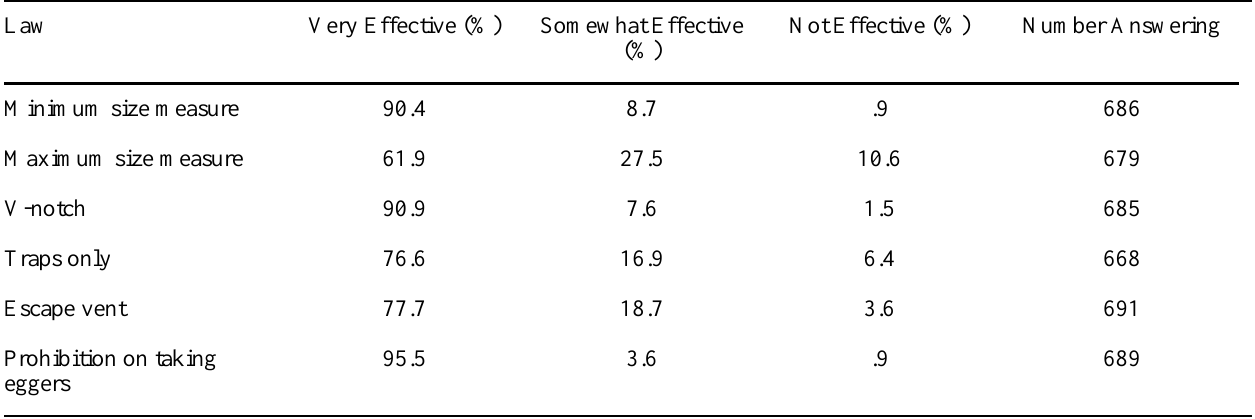
Table 1. Fishermen’s responses to the question ‘How effective are each of the following laws in conserving the lobster